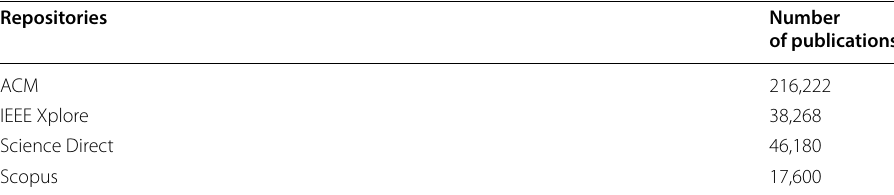
Table 2 Results of primary